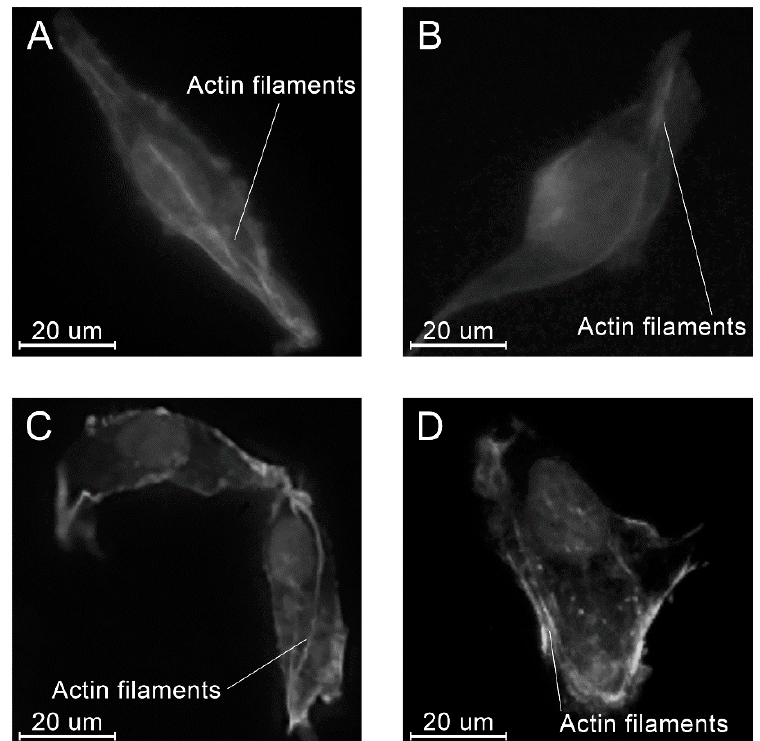
Figure 16. Examples of the morphology of the MG-63 cells, 8 h after seeding on the specimens of different materials: PLAMA-500 ( A ); PLAMA-1000 ( B ); PLDL ( C ); SS ( D ).